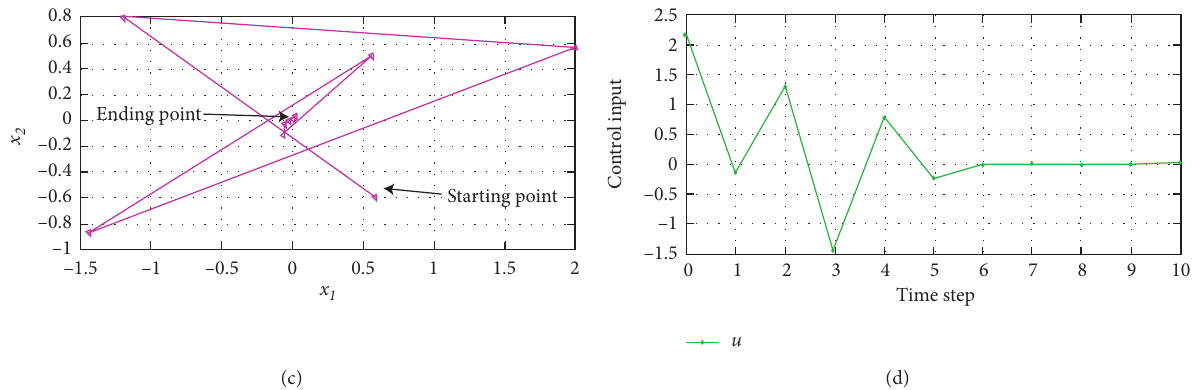
Figure 6: Simulation results: (a) system states without control; (b) system states with optimal control; (c) 2D plot of x